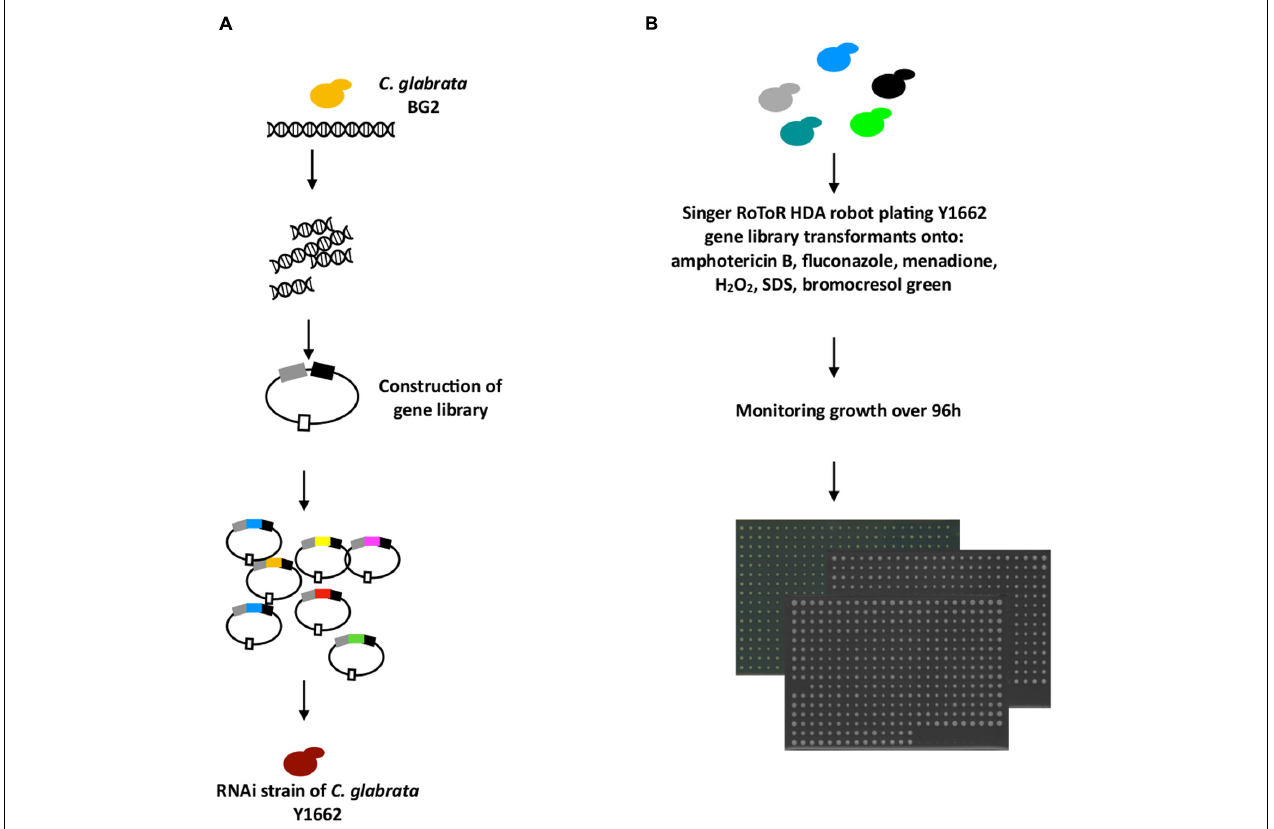
FIGURE 3 | Cloning of putative virulence genes from a gene library. (A) Genomic DNA for gene library construction was isolated from the C. glabrata BG2 strain. The DNA was partially digested with Sau 3AI and cloned into the C. glabrata multi-copy expression vector P1226 under control of the TEF1 promoter and with CYC1 terminator. This library was transformed into the RNAi-capable C. glabrata strain Y1662. (B) 1080 transformants of Y1662 containing gene library plasmids were plated from liquid YNB onto different media of interest (amphotericin B, fluconazole, menadione, hydrogen peroxide, SDS, bromocresol green) using a robotic system in 384-colony format plates. The growth of colonies was monitored by the digital imaging over 96